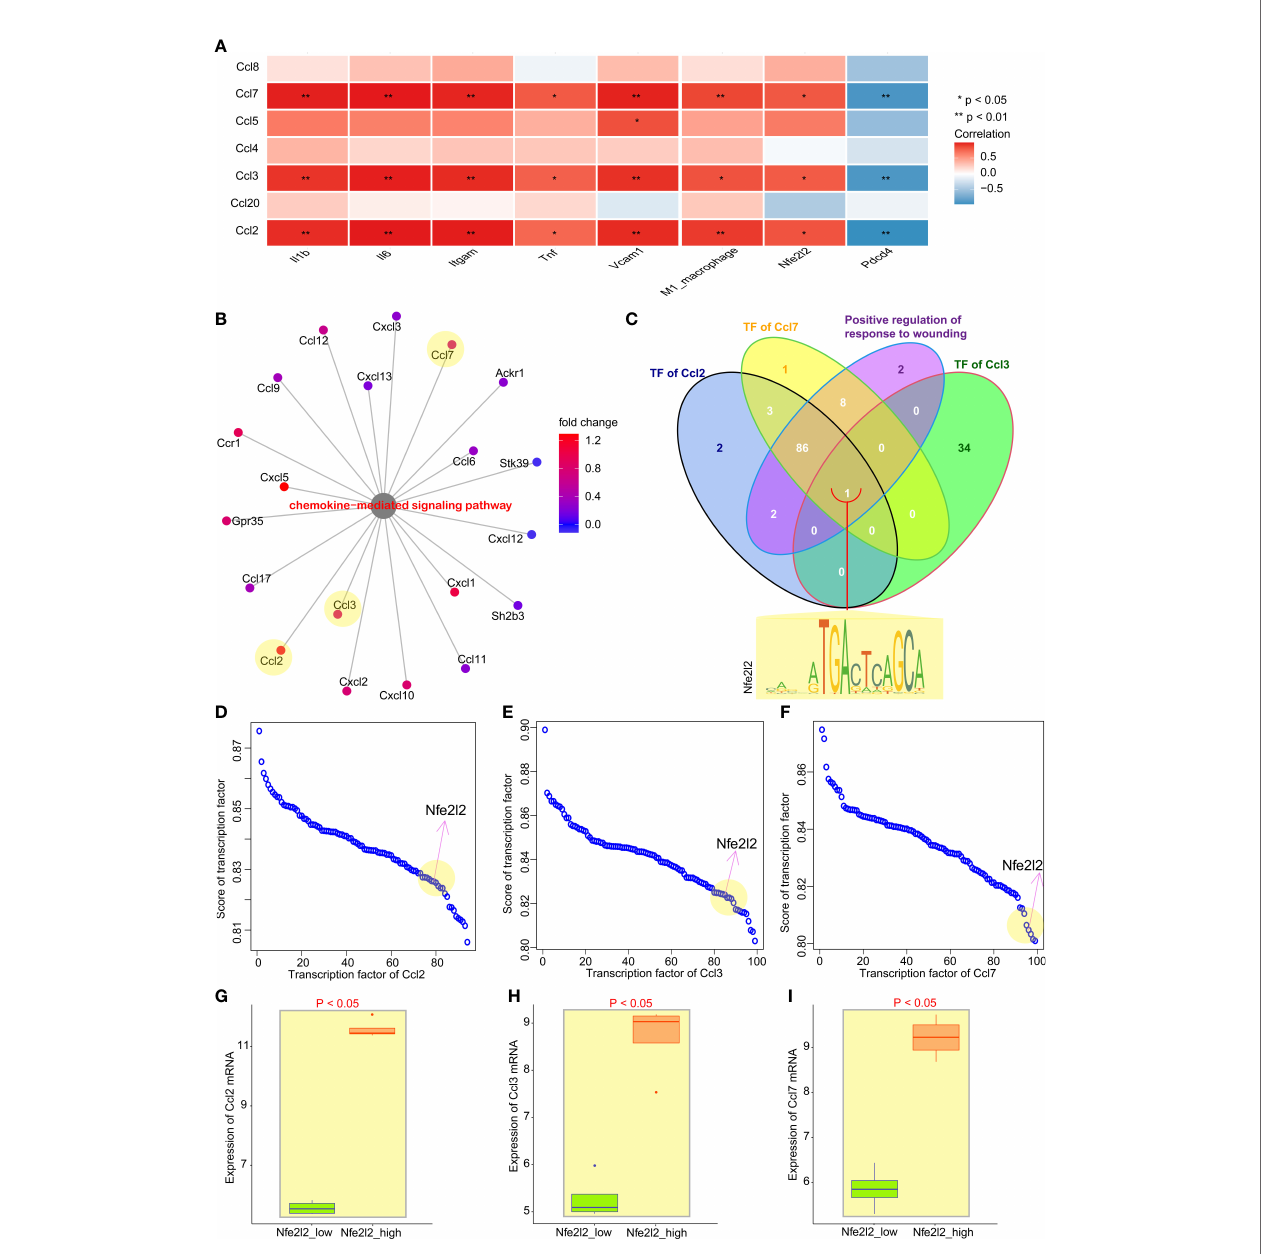
FIGURE 3 | Nrf2 cooperated with Pdcd4 to promote transcription of chemokines for macrophages. (A) Correlation analysis between chemokines for macrophages and in fl ammation factors of M1 macrophages, as well as between Nfe2l2 and PDCD4. (B) Genes enriched in term “ Chemokine-mediated signaling pathways ” . (C) Venn diagram of transcription factors of Ccl2, Ccl3, or Ccl7, as well as genes enriched in term “ Positive regulation of response to wounding ” ; Nfe2l2 was the only common gene. (D – F) Transcription factor score of Ccl2, Ccl3, or Ccl7. (G – I) Relationship between Nfe2l2 expression and the expression of Ccl2, Ccl3, and